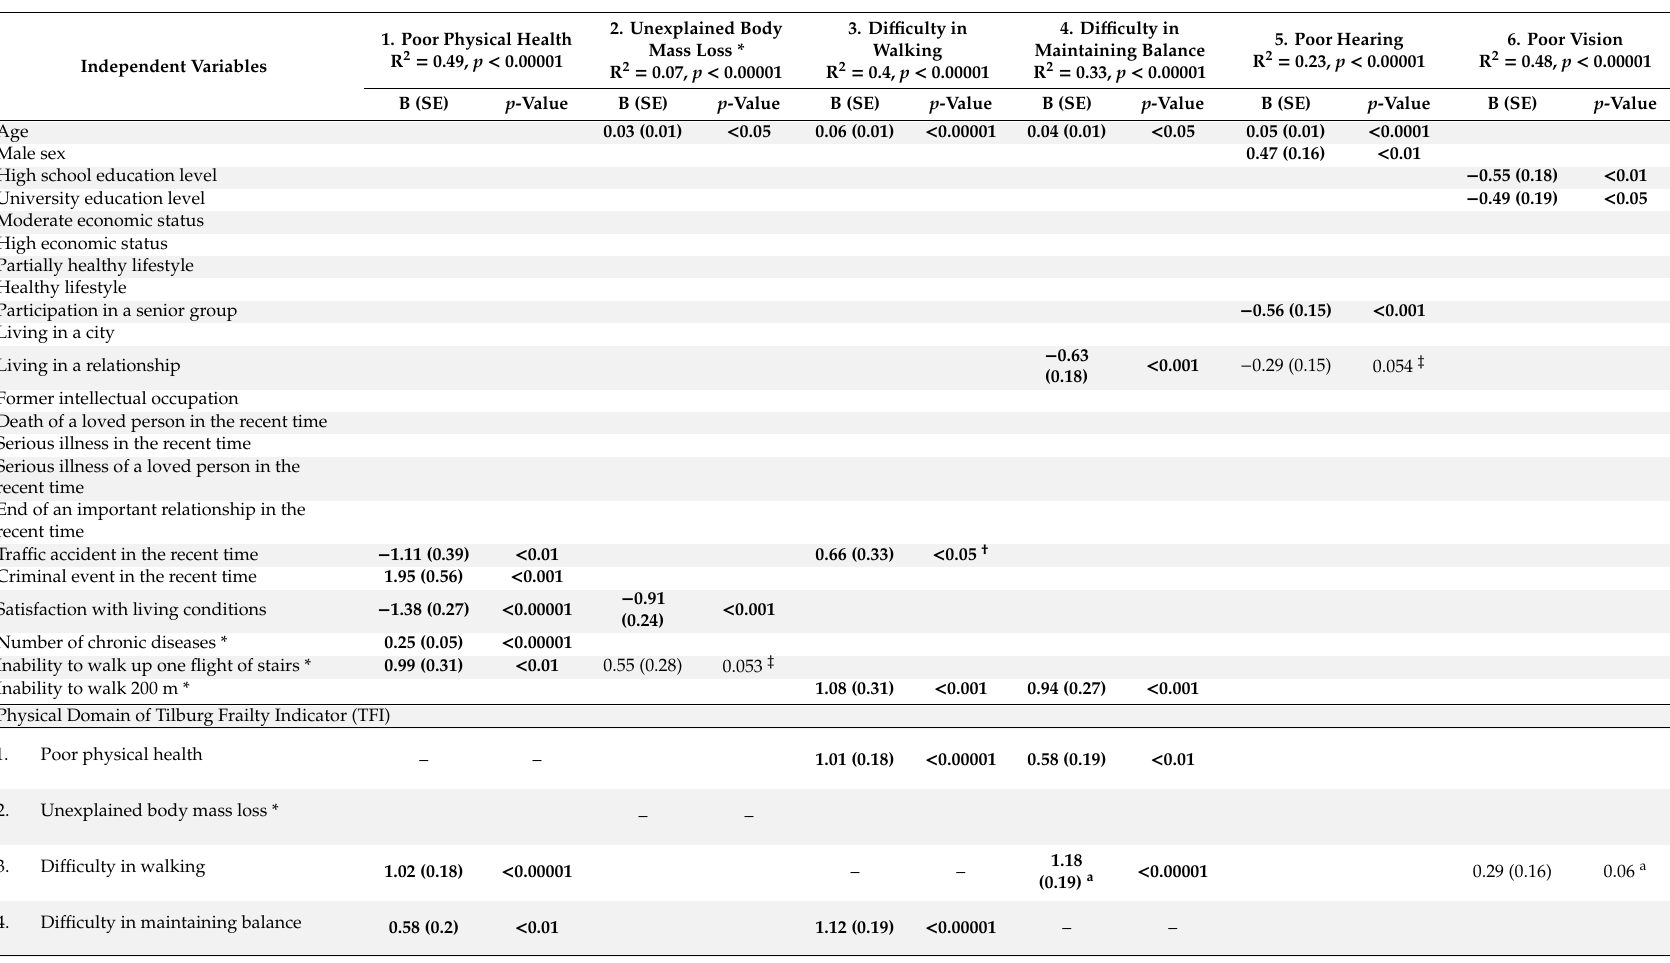
Table 3. Independent determinants for each component of TFI and the FRAIL